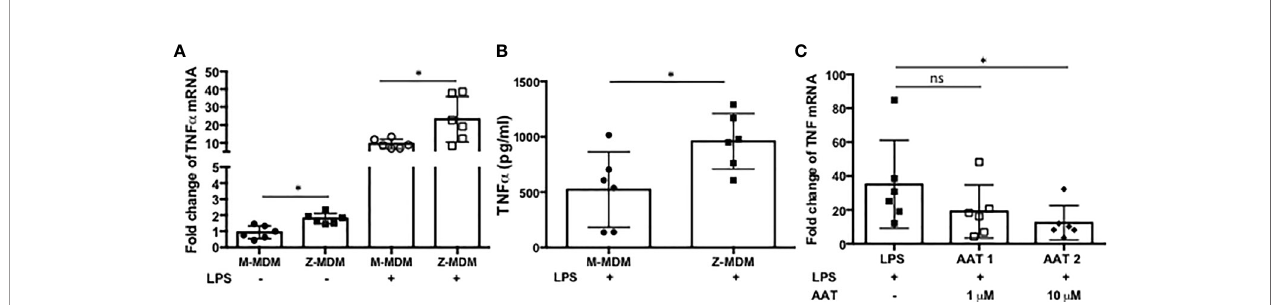
FIGURE 6 | LPS-induced TNF a expression in M- and Z-MDMs. MDMs were incubated with LPS (10 ng/ml) overnight and the gene expression level of (A) TNF a and (B) its protein level were compared between M-MDMs and Z-MDMs. (C) Z-MDMs were incubated with LPS (10 ng/ml) and two different concentrations of M- AAT overnight. The effect of M-AAT on the expression of TNF a was examined in the cells; n=6. *Denotes statistical signi fi cance (p-value < 0.05) according to two- tailed Student ’ s t-test.